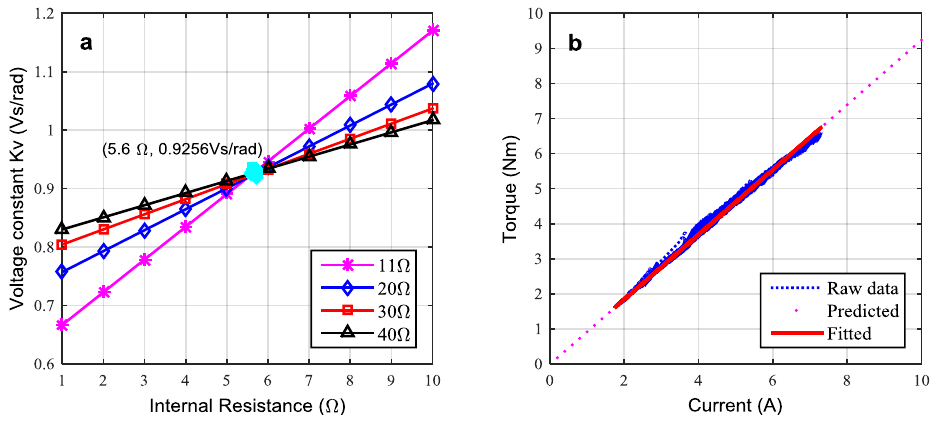
Figure 5. ( a ) Online voltage constant coefficient vs internal resistance; ( b ) online fitted torque constant coefficient, k T .